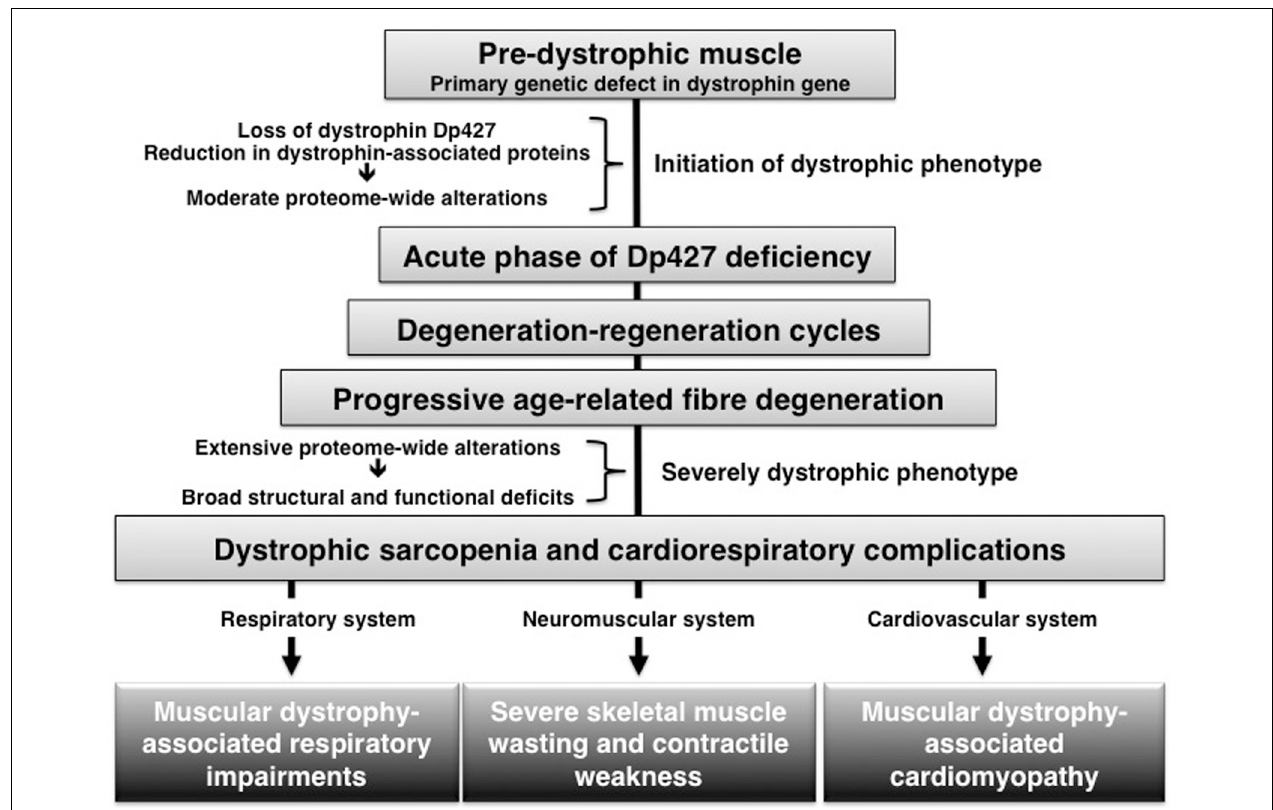
FIGURE 1 | Age-related progression of pathophysiological abnormalities in dystrophin-deficient muscle.